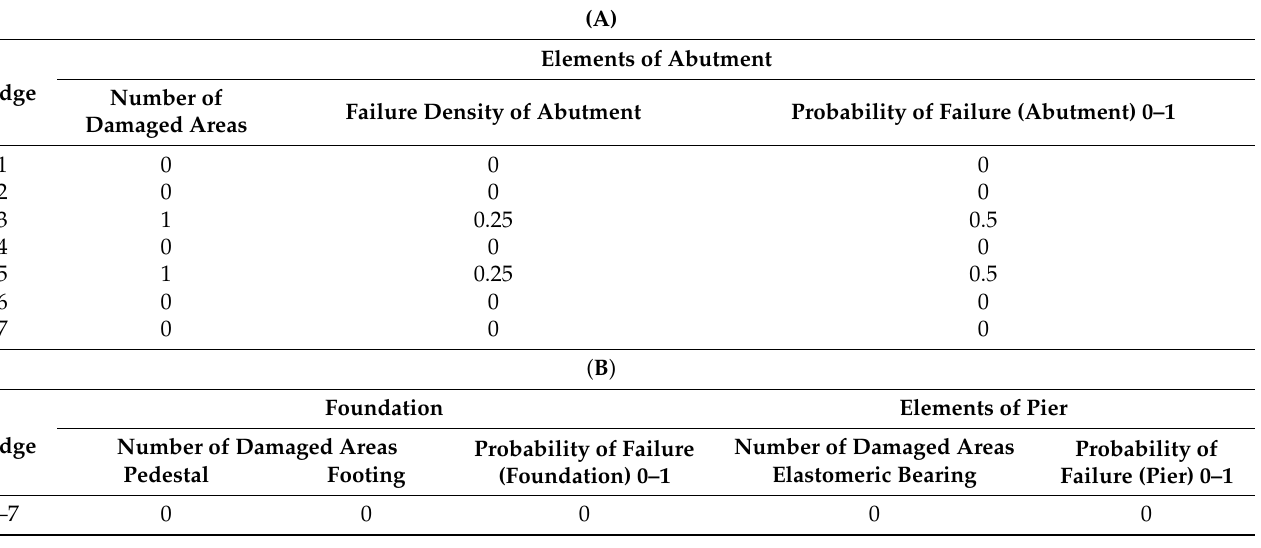
Table 3. ( A ) Probability of failure for substructure, part 1. ( B ) Probability of failure for substructure, part 2.